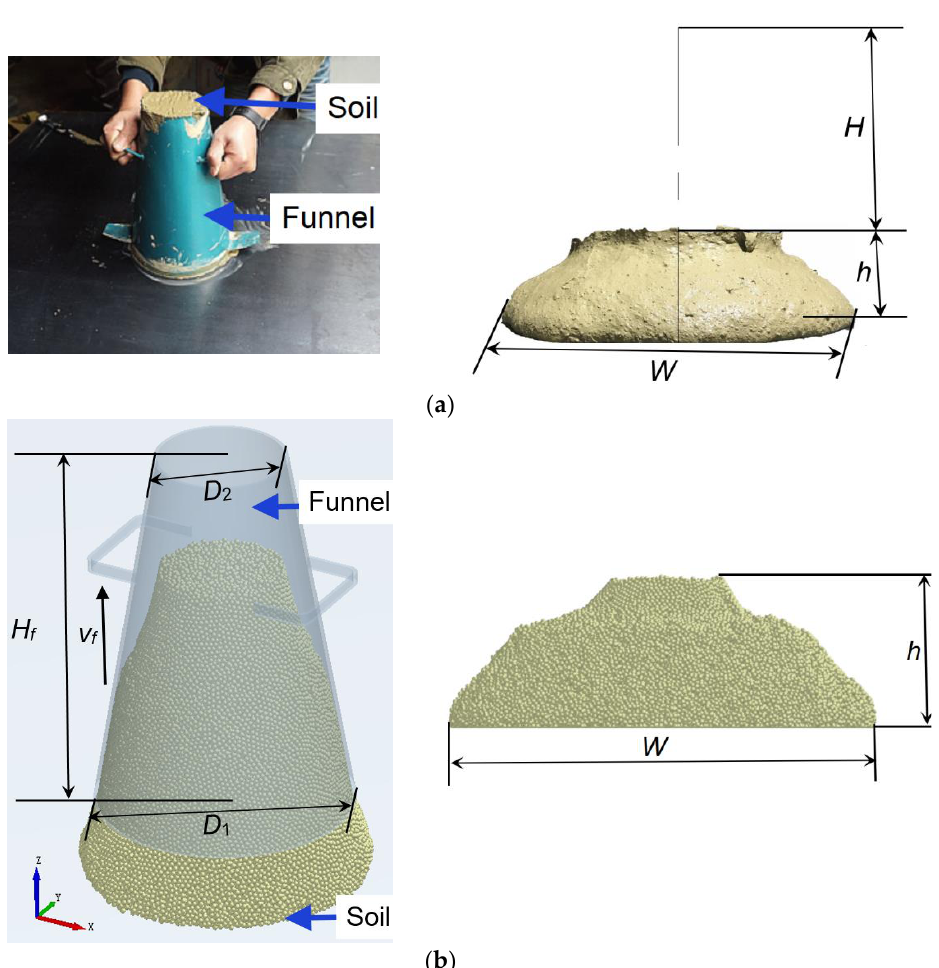
Figure 1. The slumping test and collection of slumping value ( H ) and slumping expansion ( W ) in experiments ( a ) and DEM simulations ( b ). ( H f , h , D 1 , and D 2 stand for funnel height, final soil height, lower opening diameter, and upper opening diameter of the funnel, respectively; v f stands for travel speed of the funnel).